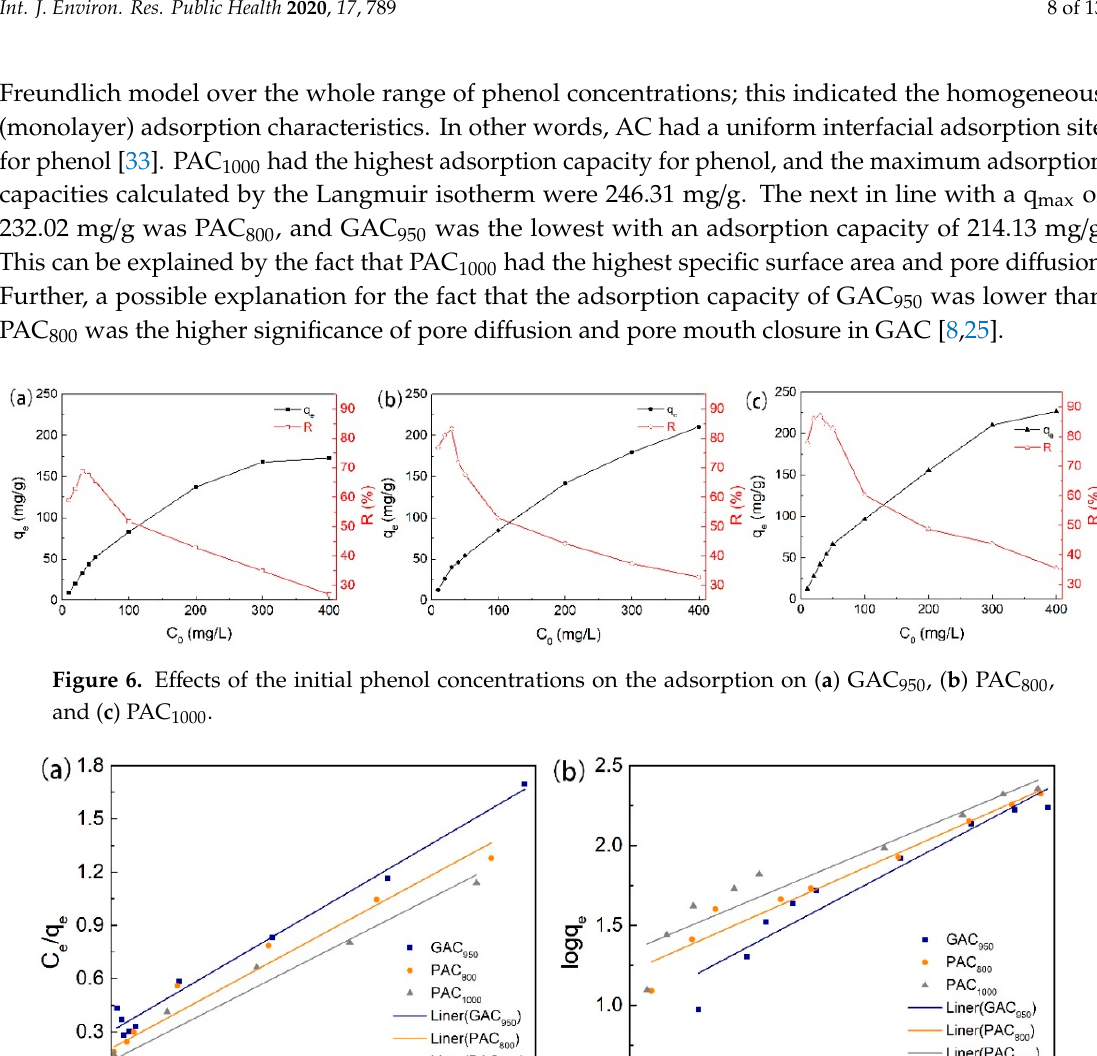
Figure 7. Fitting curves of adsorption on phenol through the Langmuir (a) and Freundlich (b) models. Table 2. Equilibrium parameters for phenol adsorption onto AC.